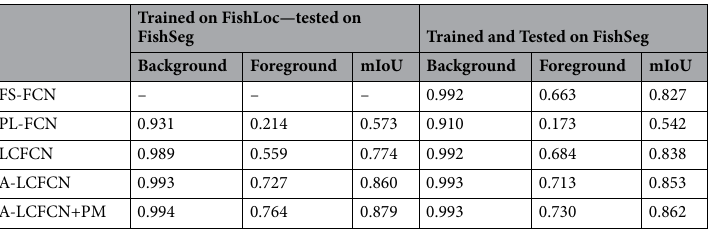
Table 1. Comparison between methods evaluated on the FishSeg test set, trained on either the FishLoc train set or the FishSeg train set. Foreground is the IoU between the predicted fish segmentation and their ground- truth, and Background is the IoU between the predicted background segmentation and its ground-truth. The annotation budget for FS-FCN and the methods trained on FishLoc was around 1500 seconds.